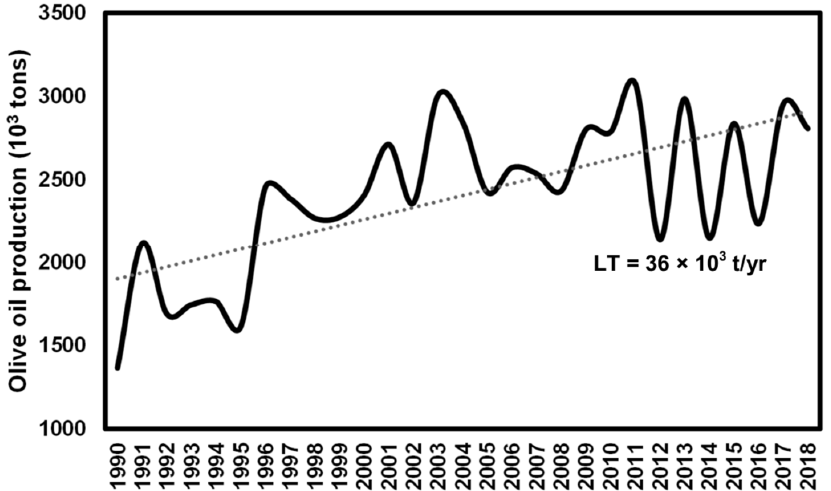
Figure 1. Olive oil production (tons) from 1990 to 2018 along with the linear trend (LT), adapted from [8].